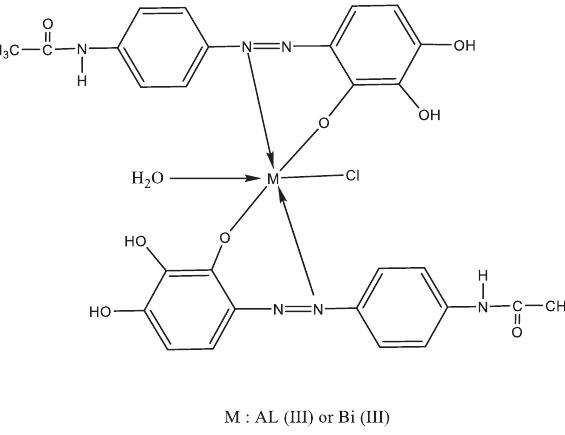
Figure 26: Suggested structure of the formed